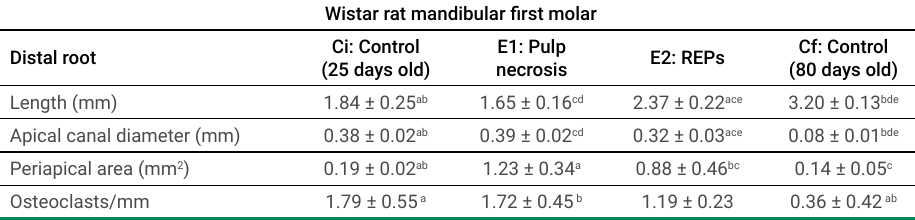
Table 1. Mean values and standard deviations of the distal root length and canal diameter, size of the periapical area and osteoclastic activity. Wistar rat mandibular first molar